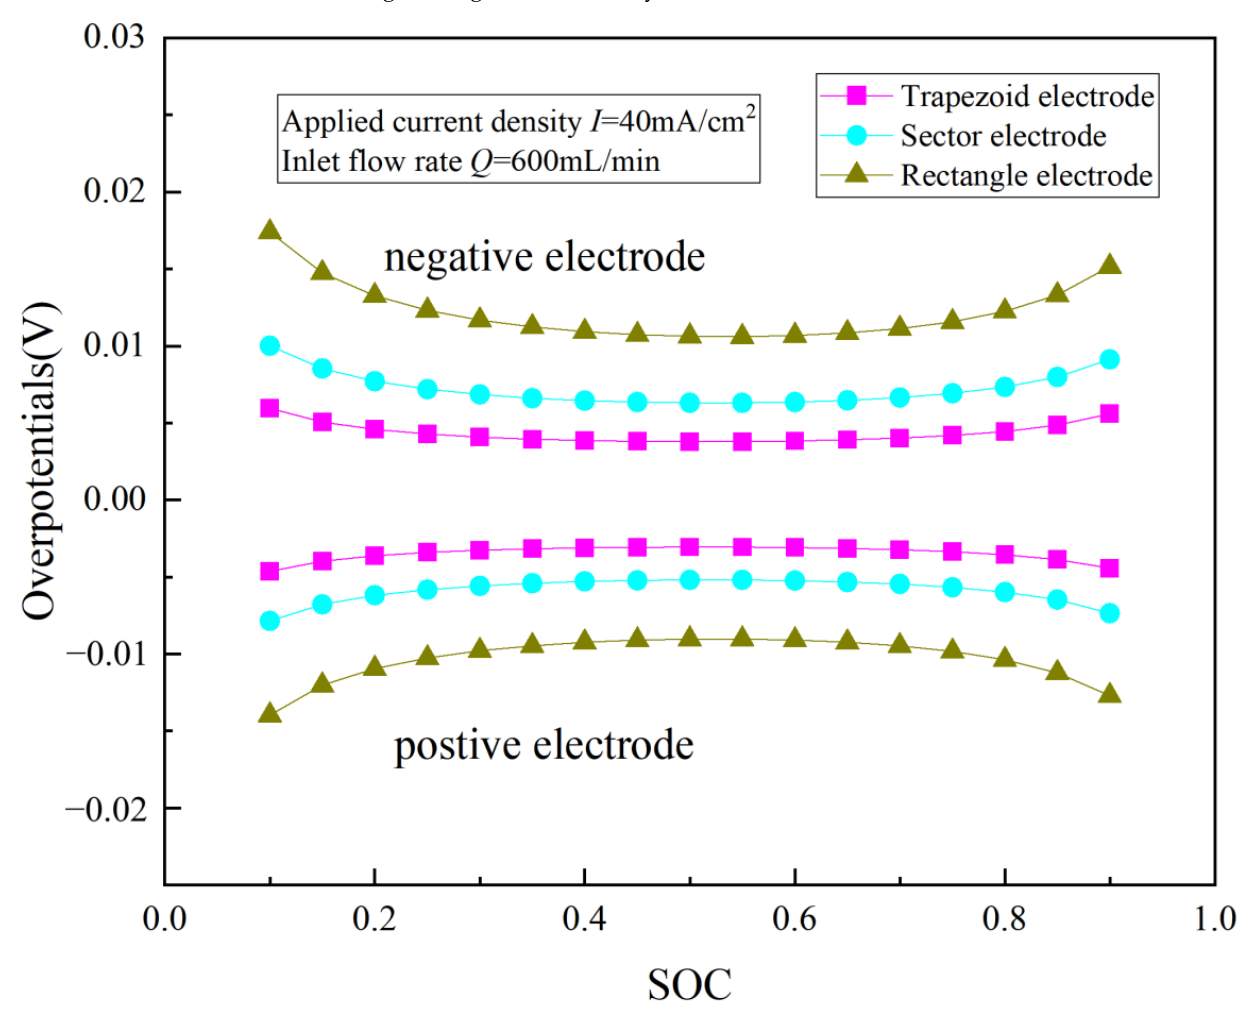
Figure 4. Variations in electrode overpotentials during discharge process using different elec- trodes.